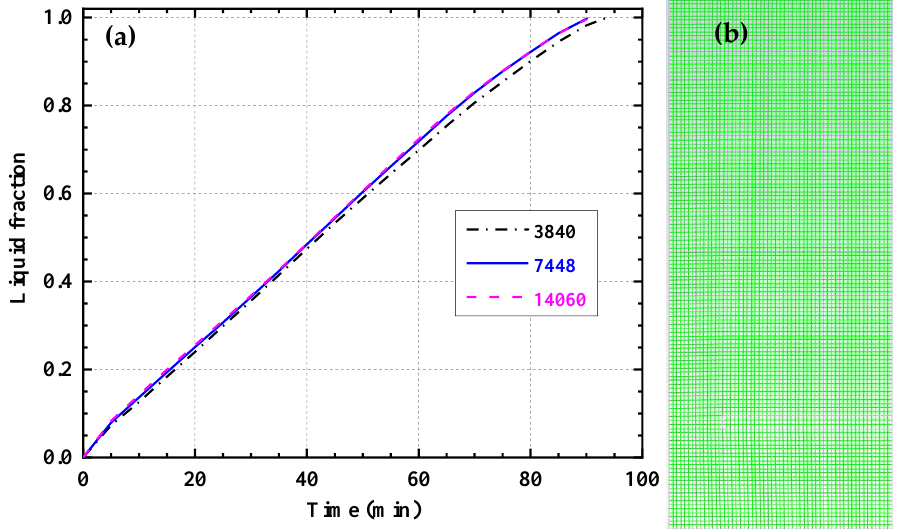
Figure 2. ( a ) Grid independency test results. ( b ) Schematic view of the used